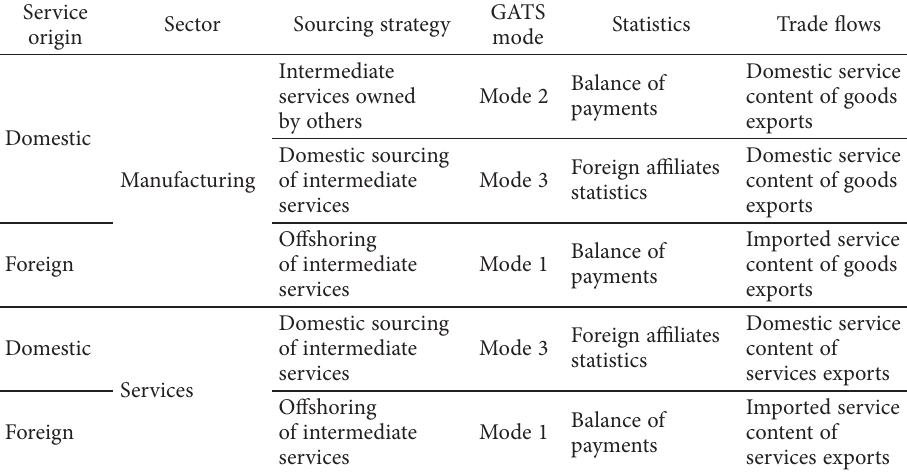
Table 1. The role of intermediate services in global value chains and trade patterns Service